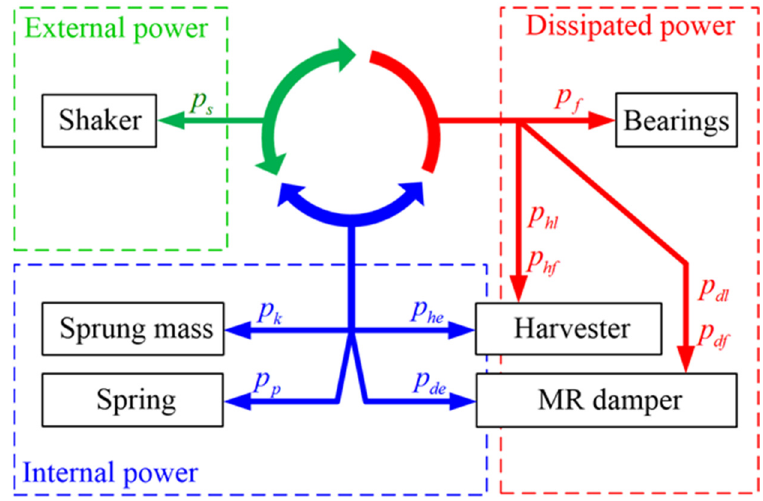
Figure 7. Power flows diagram. Table 1. Type of power in the context of energy flows.